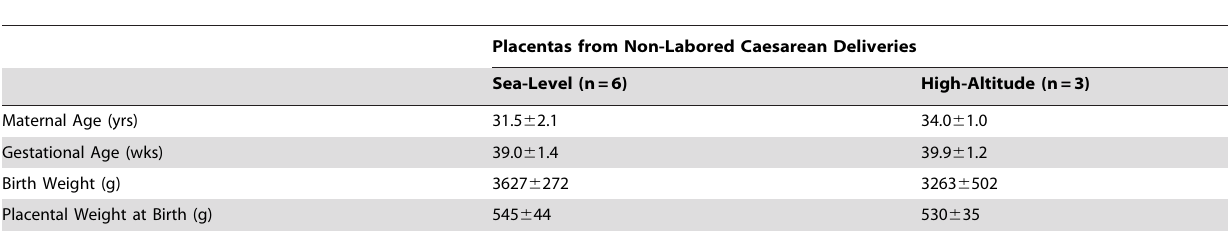
Table 1. Clinical characteristics of sea-level and high-altitude pregnancies; placental samples from non-labored, caesarean deliveries were used for ETS complex protein, mRNA and microRNA analyses in this study.